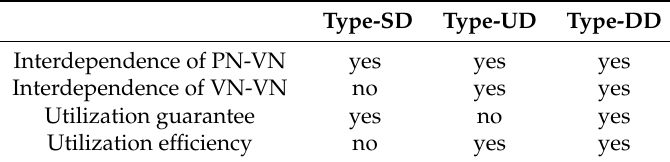
Table 3. Characteristics of three resource partitioning schemes for PV-NoN